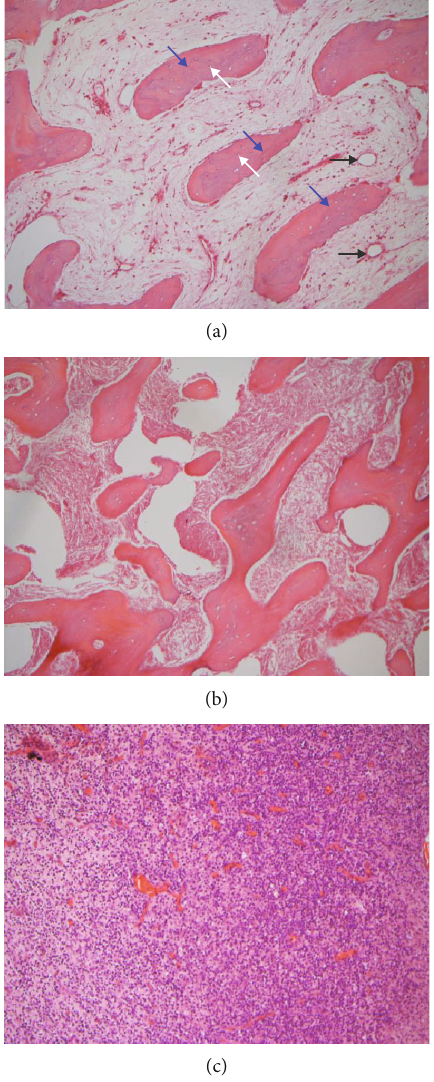
Figure 6: Models of defects B1 and B2 and histology. The pathological section stained with hematoxylin-eosin stain 12 weeks after reconstruction. White arrows indicate osteocytes, blue arrows indicate lamination, and black arrows indicate vessels in the marrow region. (a) The treatment defect B1 of the Tibia 3 , showing apparent lamination like as defect A1. (b) The section obtained from one end of the treatment defect B2, showing normal bone formation. (c) The section obtained in the middle of the treatment defect B2 of the Tibia 4 , showing granulation